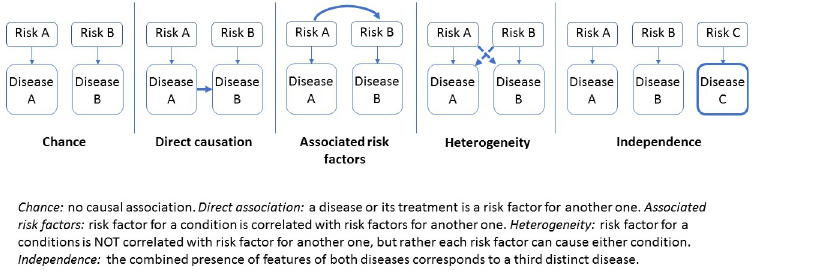
Fig 2. Typology of etiological associations between comorbid conditions.